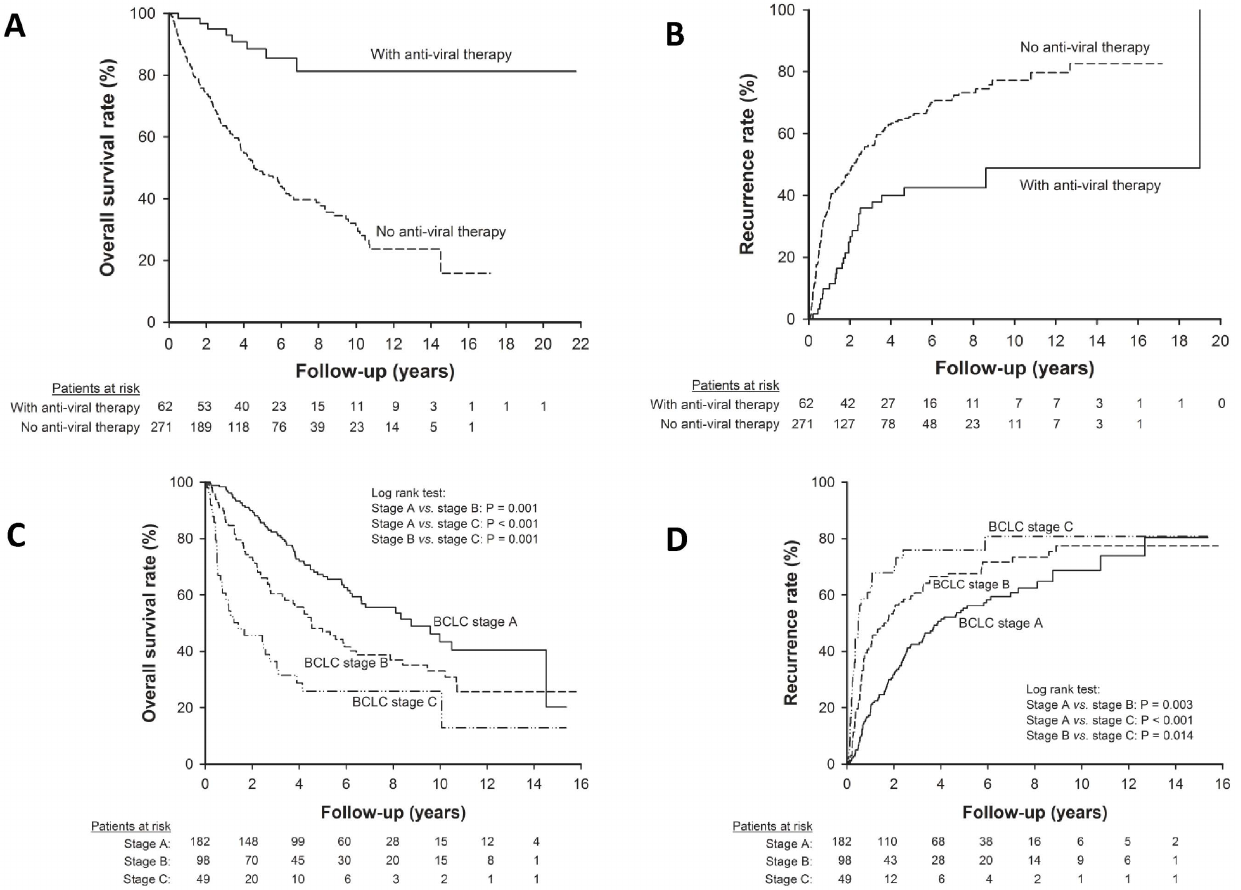
Figure 1. The impact of anti-viral therapy and tumor stage on post-operative prognosis. Patients who received anti-viral therapy after resection had ( A ) higher overall survival rate ( p , 0.001) and ( B ) lower recurrence rate ( p , 0.001) than those who did not receive anti-viral therapy. Moreover, patients in BCLC stage C HCC had lower overall survival rate ( C ) and higher recurrence rate ( D ) than those in BCLC stage A or B.